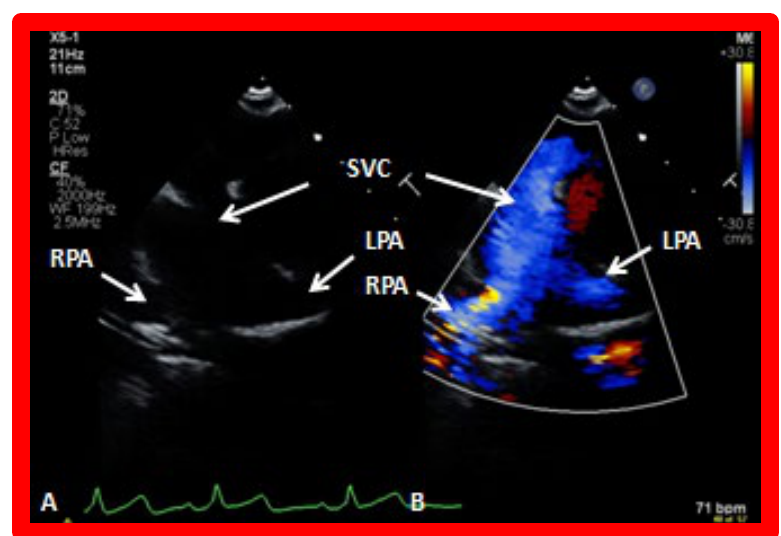
Figure 27. Selected video frames from suprasternal notch view demonstrating bidirectional Glenn shunt; the superior vena cava (SVC) is shown emptying into the right (RPA) and left (LPA) pulmonary arteries by two dimensional ( A ) and color flow imaging ( B ). Both RPA and LPA are seen with color in contrast to that seen in Figure 26, probably related to both pulmonary arteries are in a similar echo plane.